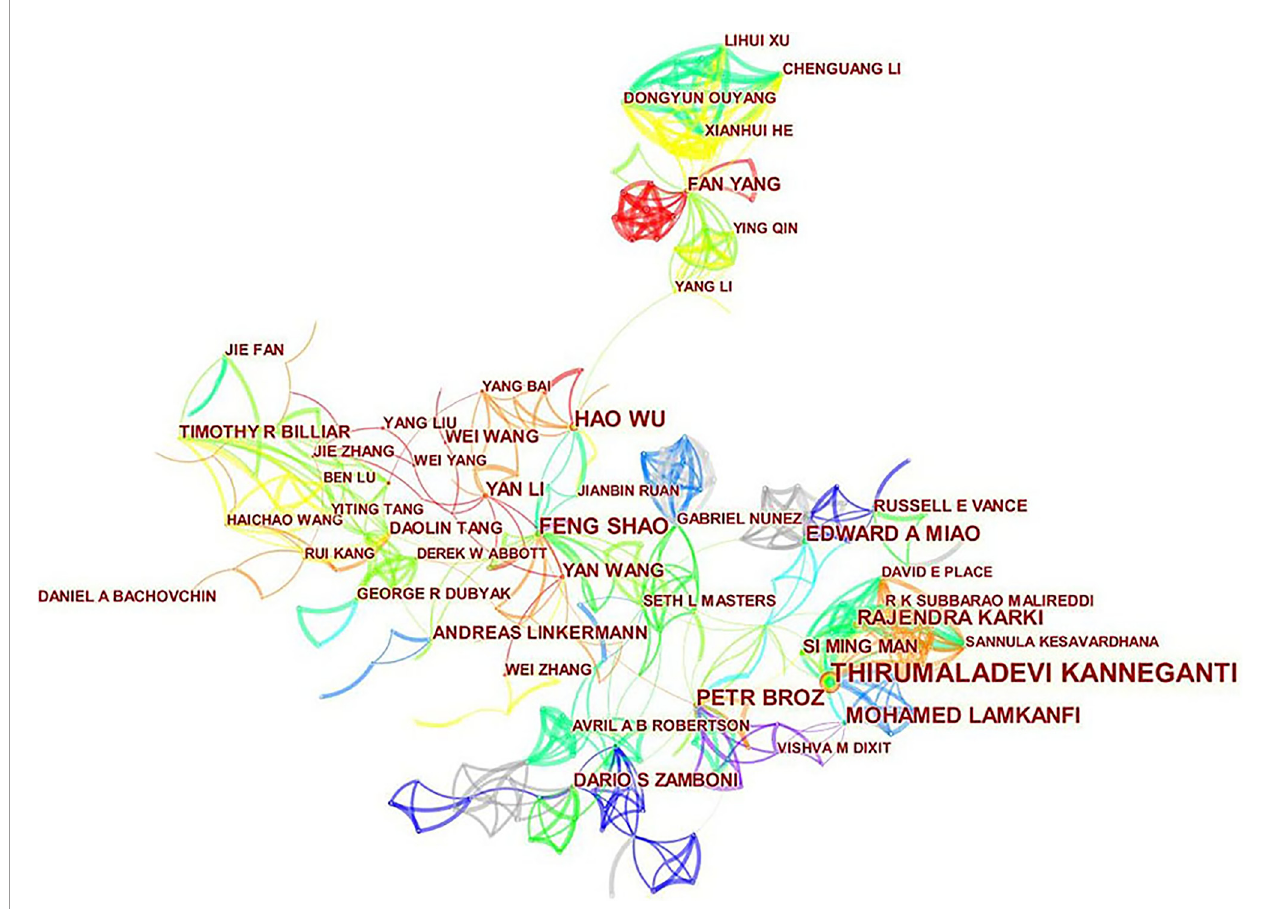
FIGURE 5 | CiteSpace visualization map of authors involved in pyroptosis.